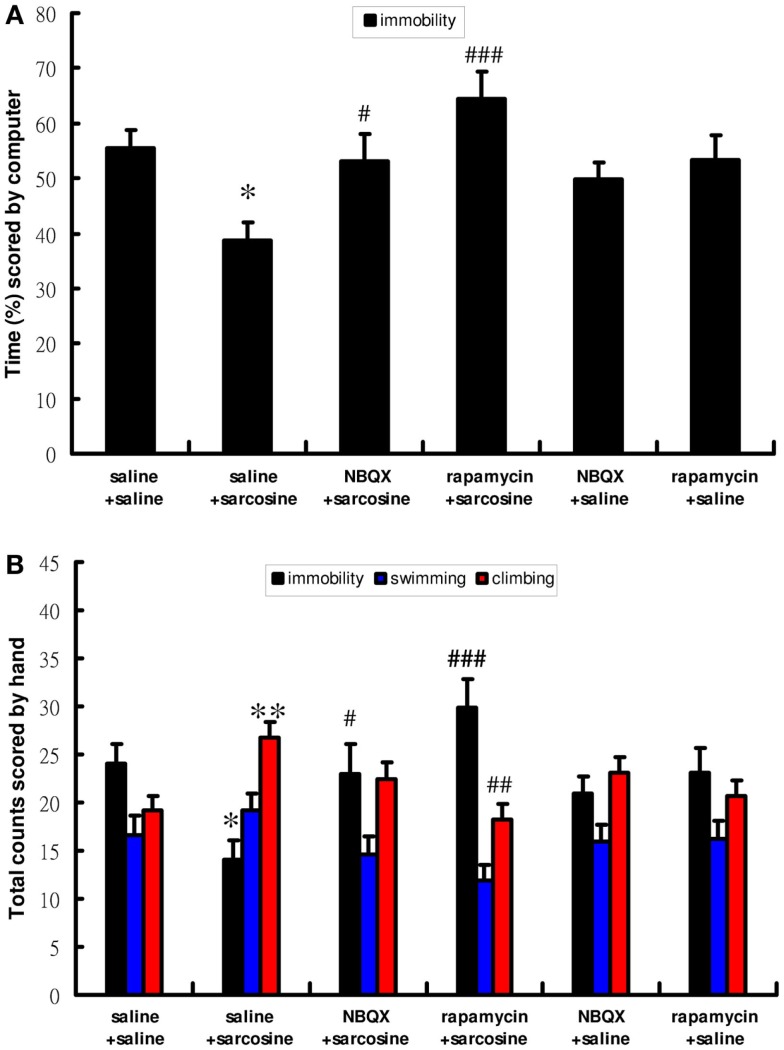
The behaviors scored by computer (A) (percentage of immobility time) and manually (B) (frequency of immobility, swimming, climbing) of rats after acute sarcosine (560 mg/kg, i.p.) administration with pretreatment with NBQX (10 mg/kg, i.p.) or rapamycin (20 mg/kg, i.p.) in FST test. Note that the decreased immobility and increased climbing resulted from acute sarcosine treatment is blocked when rats were pretreated with rapamycin. Similar effect is evidently observed when rats were pretreated with NBQX. (*p < 0.05; **p < 0.01 compared with saline/saline-treated group; #p < 0.05, ##p < 0.01 compared with saline/sarcosine-treated group with Tukey post hoc analysis, Values shown are mean ± SEM, n = 8–9 per group).